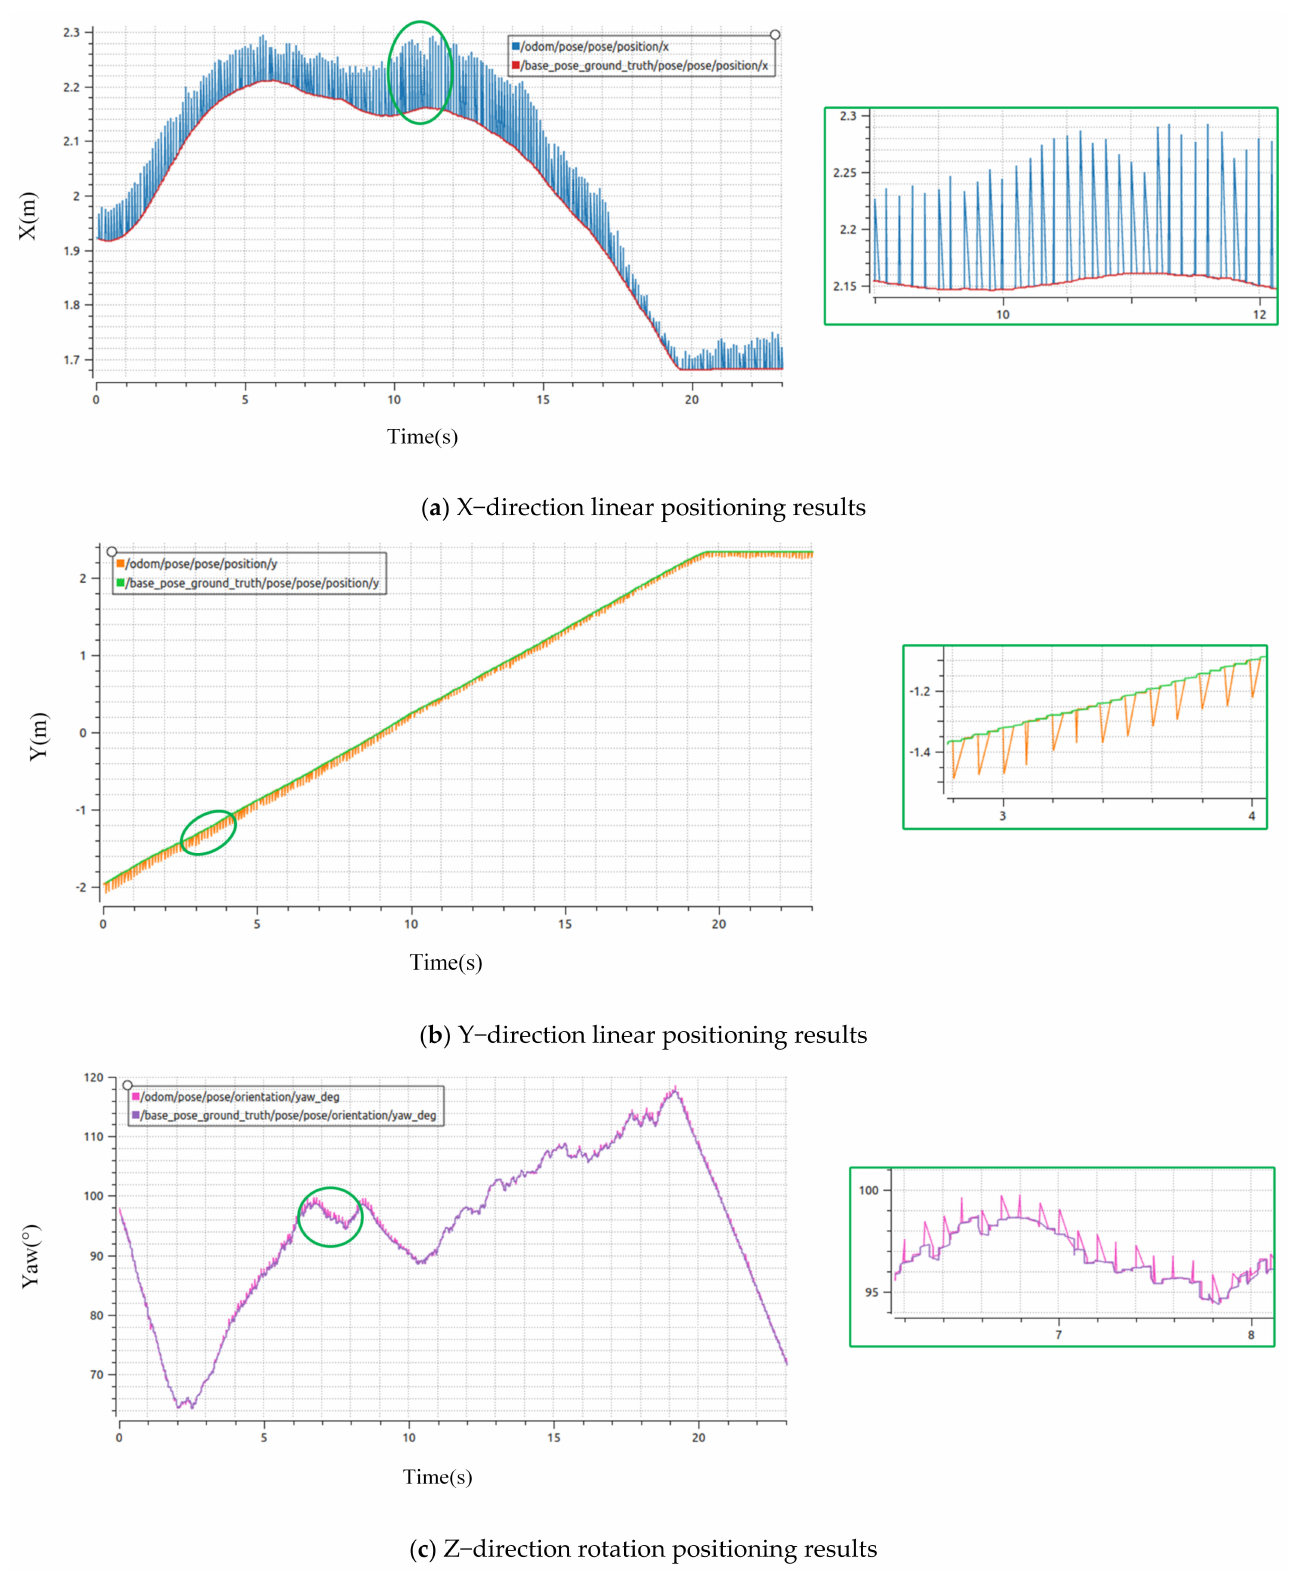
Figure 17. Results of the third group of hdl_localization simulation positioning